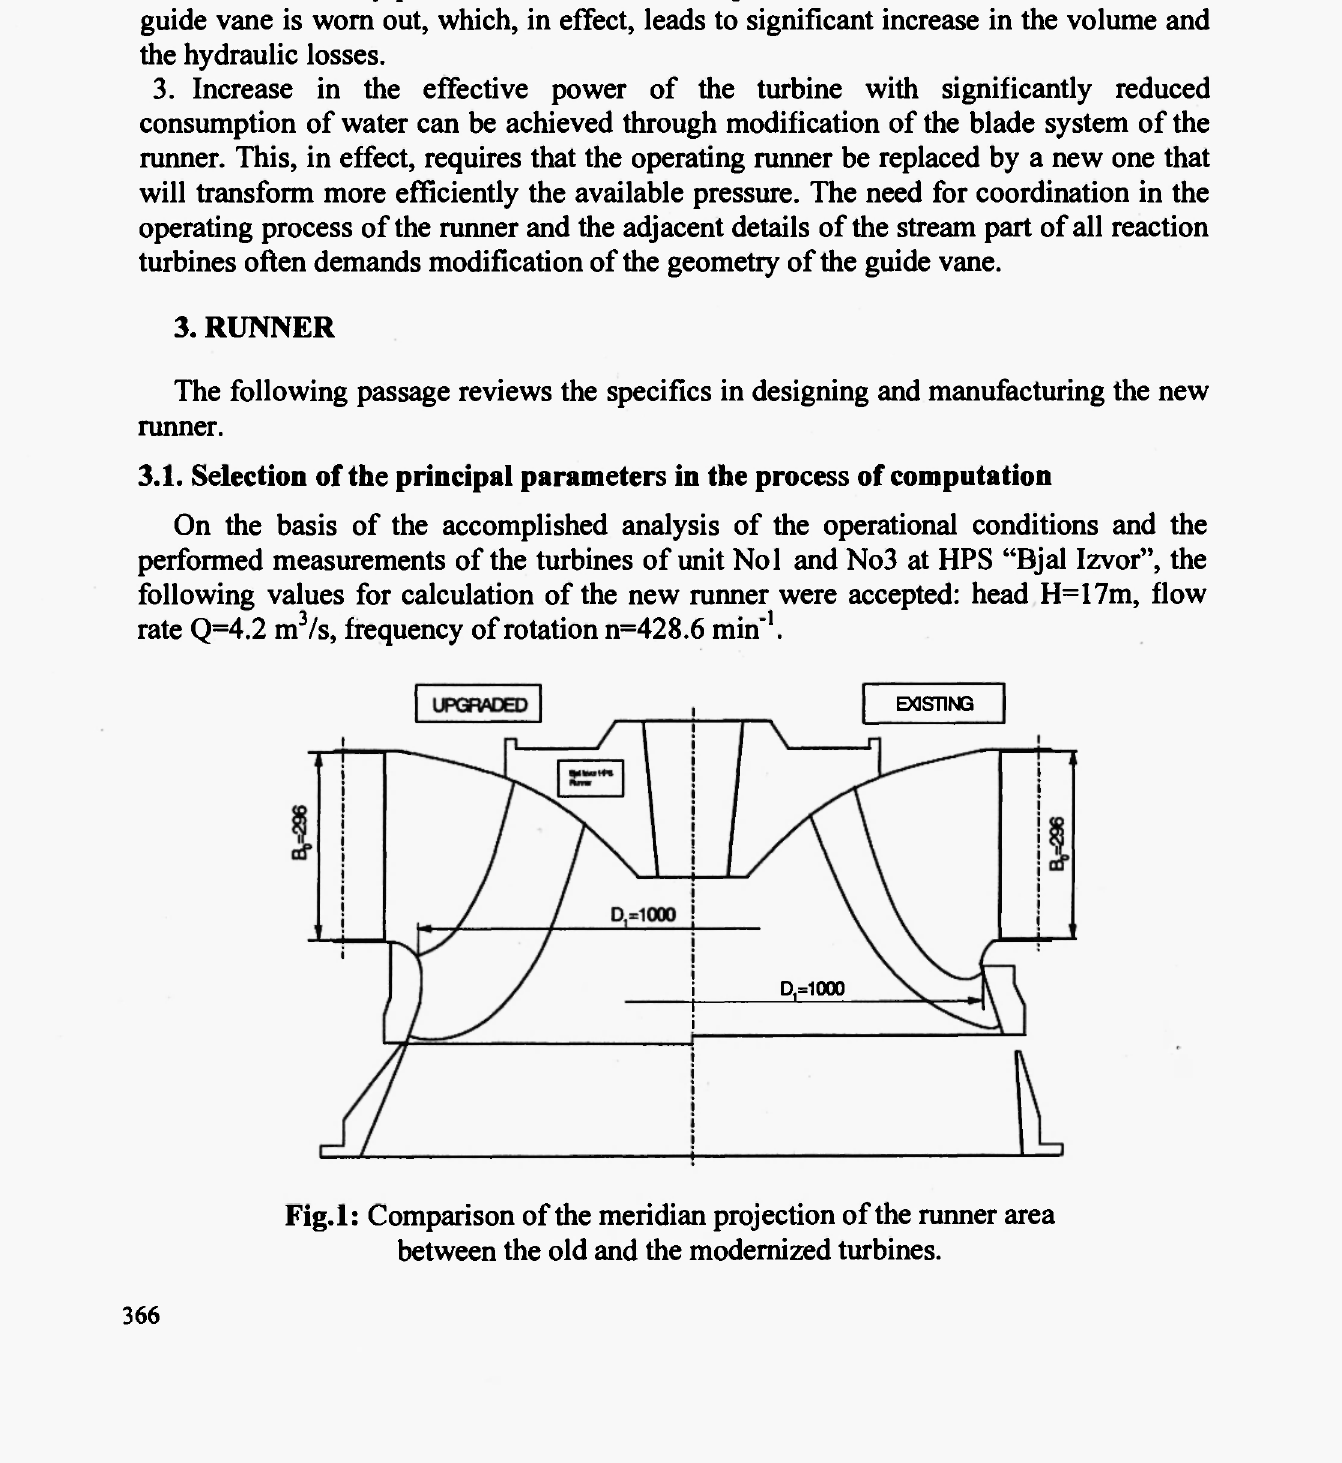
Fig.l: Comparison of the meridian projection of the runner area between the old and the modernized